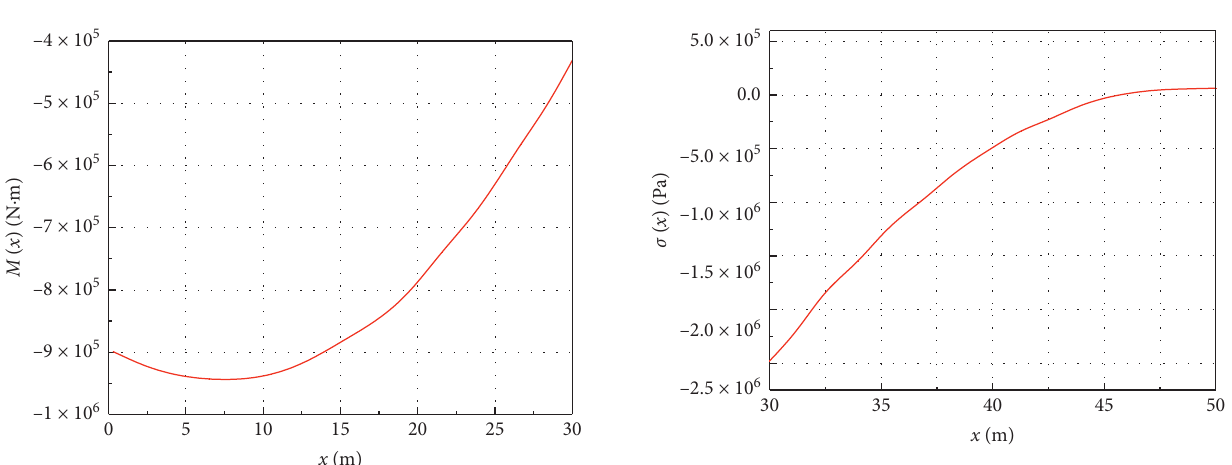
Figure 6: The variation of bending stress (II).